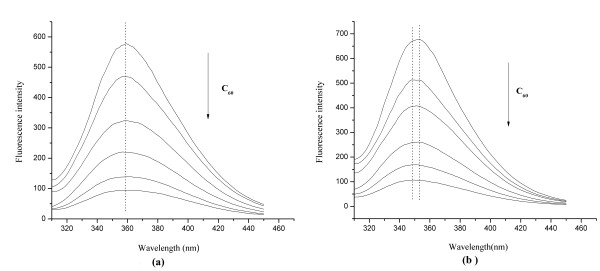
The fluorescence spectra of HSA (a) and BSA (b) in the absence and presence of C60nanoparticles. Conditions: HSA/BSA: 1.0 × 10-5 mol/L; C60 (from up to down): 0, 1.39, 2.78, 5.56, 8.34, 11.12 × 10-6 mol/L; pH = 7.4; ex = 292 nm.